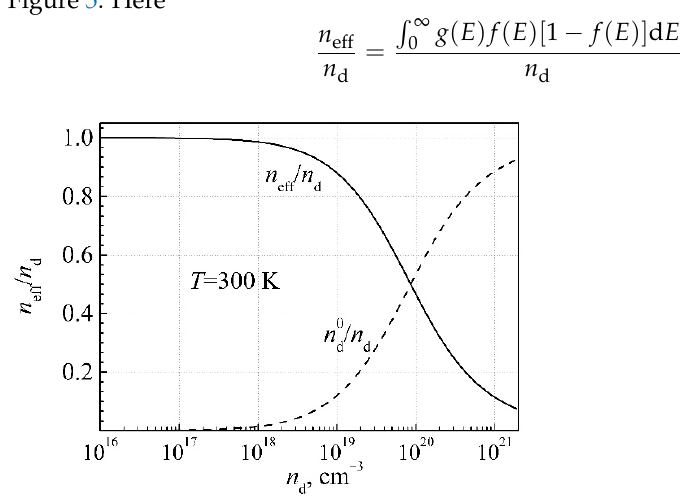
Figure 5. The relative densities of the effective free RM electrons (solid line) and neutral (non-ionized) phosphorous donors (dash line) dependences on the donor doping density at T = 300 K.